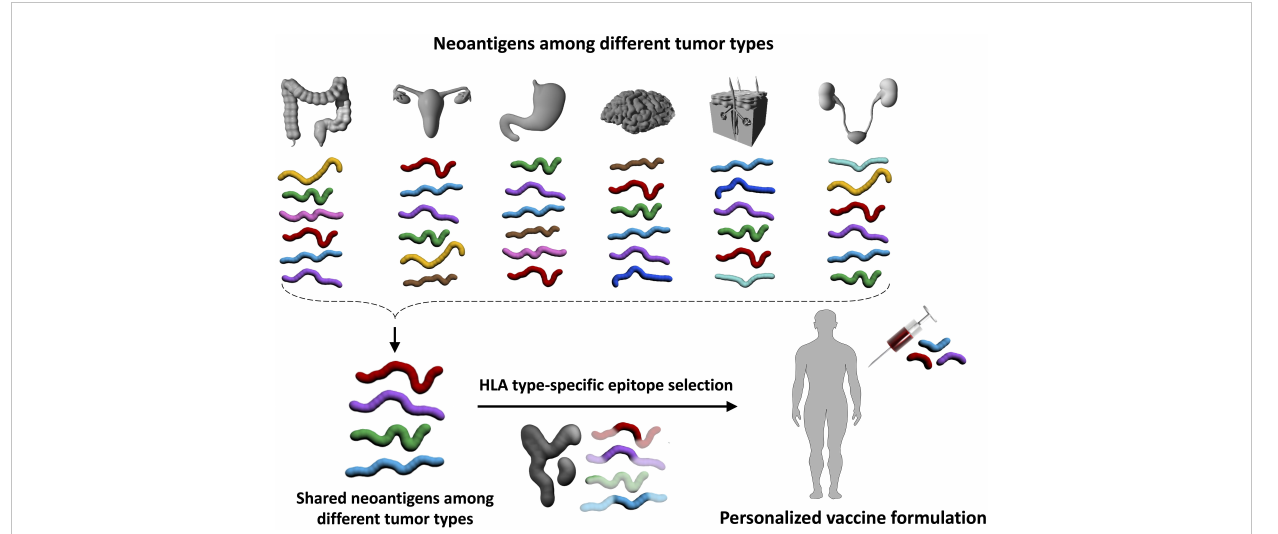
FIGURE 3 Immunopreventive potential of neoantigens shared by tumors in different organs. In addition to the characteristic LS-associated tumors in the colorectum and endometrium, the tumor spectrum in LS also encompasses other organs such as brain, skin, and kidney tumors. It is possible that certain neoantigens are shared across different tumor types (red, purple, green, and aqua blue antigens in the upper panel). Immunopreventive vaccines with these shared neoantigens that are further adjusted by an individual ’ s HLA genotype may allow the development of a personalized, preventive vaccine without organ restriction. Such an approach would be particularly valuable for cancers without screening options. This is illustrated by the example in the lower panel of the fi gure, where one of the shared neoantigens (green) is not included in the vaccine formulation because this green antigen does not contain neoepitopes that bind to the individual ’ s HLA